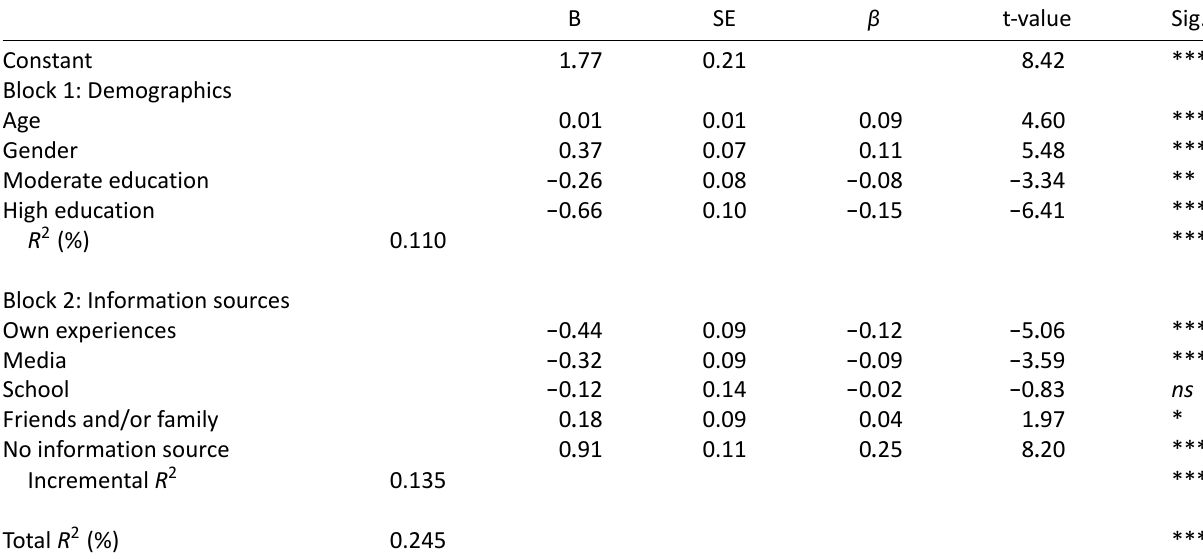
Table 4. The predictors of algorithmic misconceptions.